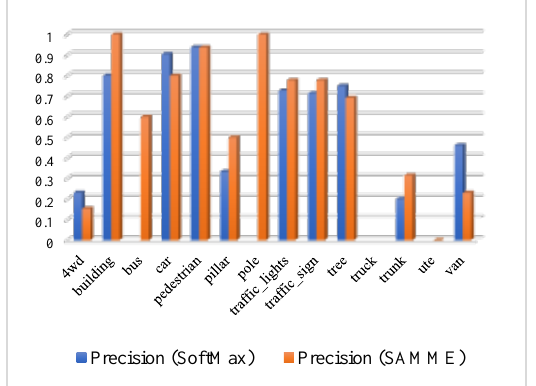
Figure 6. The Recall of SoftMax and SAMME algorithms on feature instances extracted from the fully connected layer of the trained Vox-Net model.